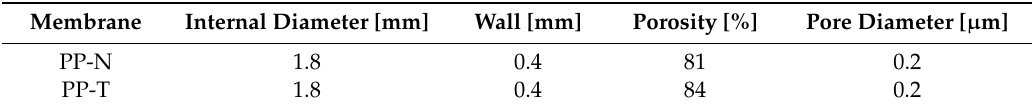
Table 1. The parameters of applied membranes.